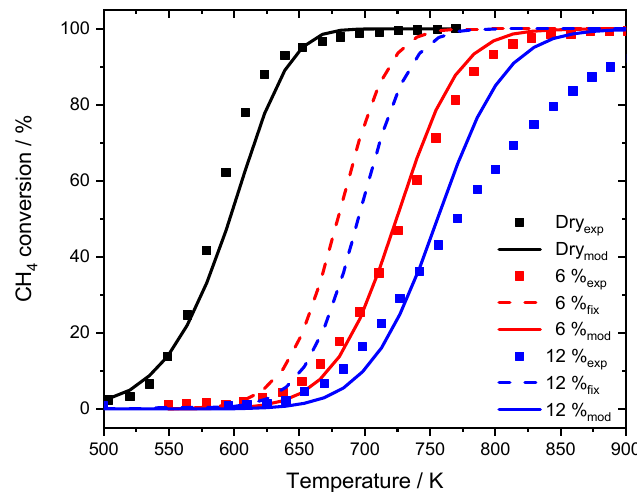
Figure 7. Experimental data published by Stotz et al. [25], for 1000 ppm CH 4 , 10% O 2 in N 2 in the absence of steam (black dots) and the modeling results (black line). Experiments in the presence of 6% externally dosed water are shown in red, 12% are depicted in blue. Modeling results are shown for the fixed dispersion value (red dashed line for 6% H 2 O, blue dashed line for 12% H 2 O) and for the modified model (red line for 6% H 2 O, blue line for 12% H 2 O). GHSV = 60,000 h − 1 .